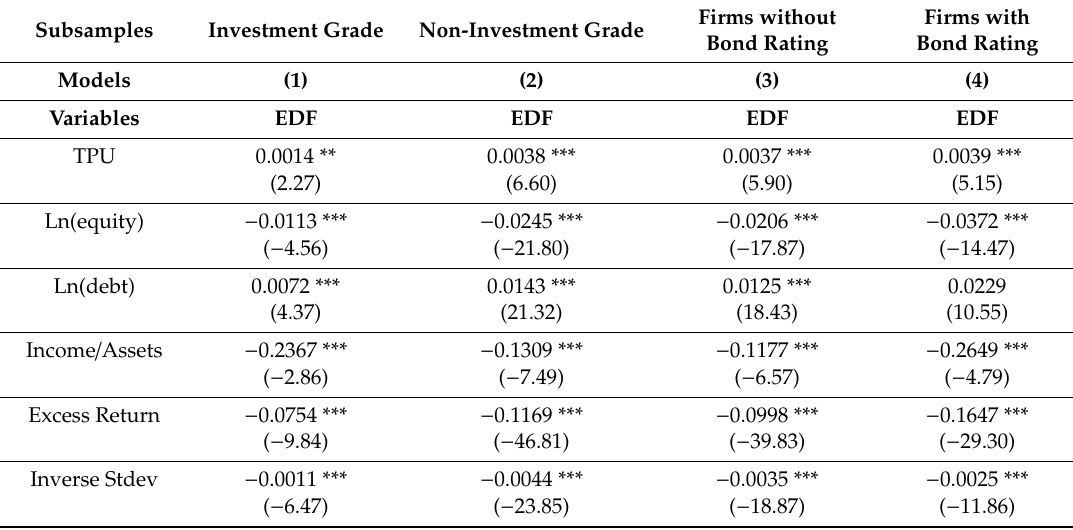
Table 6. Impact of tax policy uncertainty on default risk conditioned on credit quality and access to